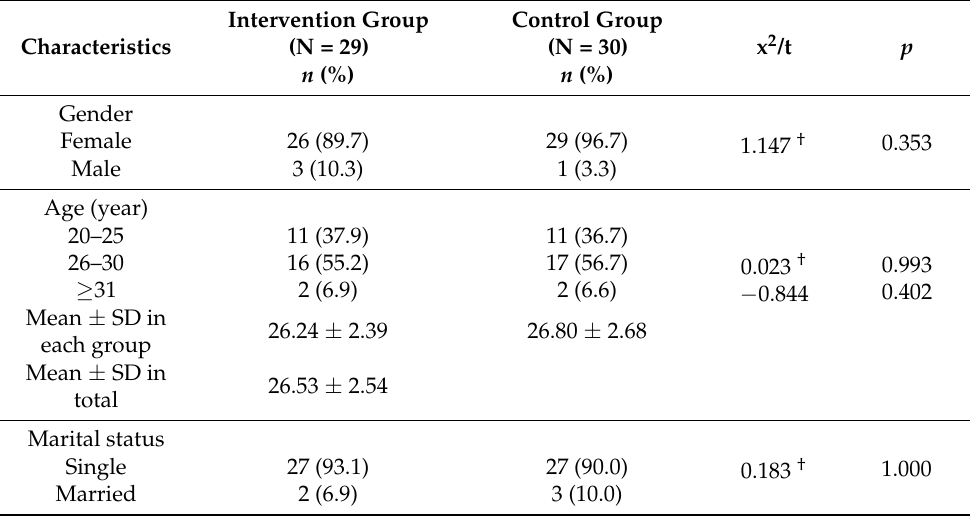
Table 1. General characteristics of participants and